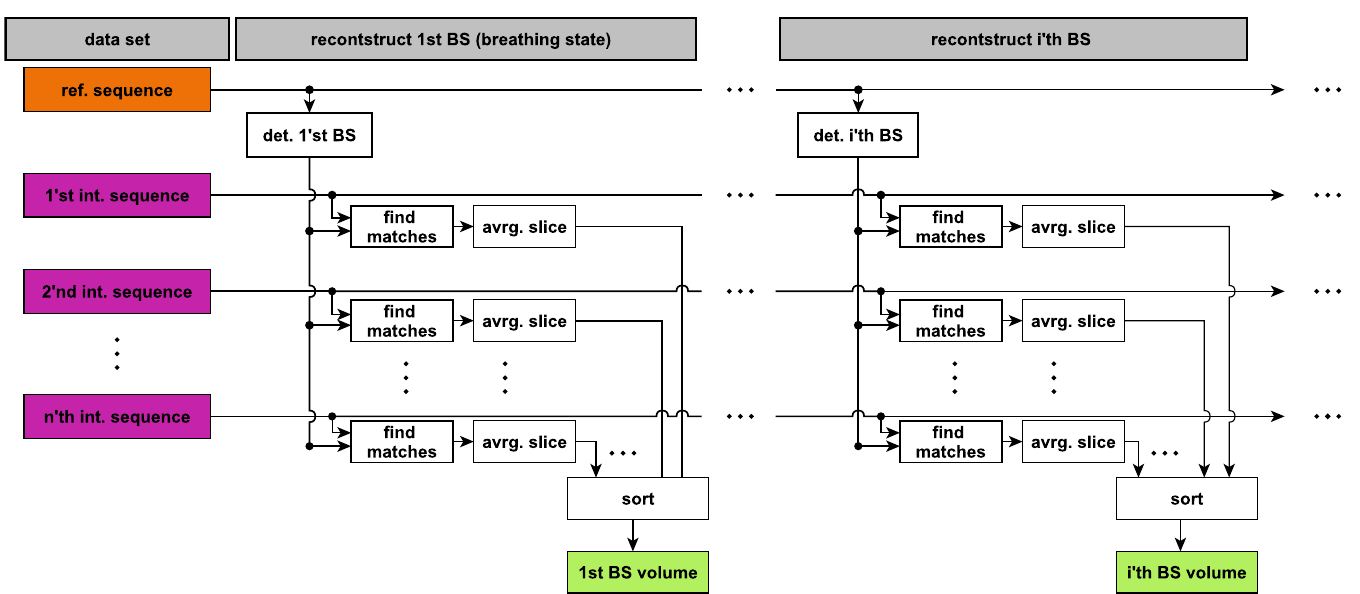
Fig 4. Scheme of 4D MRI reconstruction. For each time point in the reference sequence, a volume is reconstructed. For that in each interleaved sequence, the data slices are found that match the breathing state. They are then averaged and sorted into a volume.